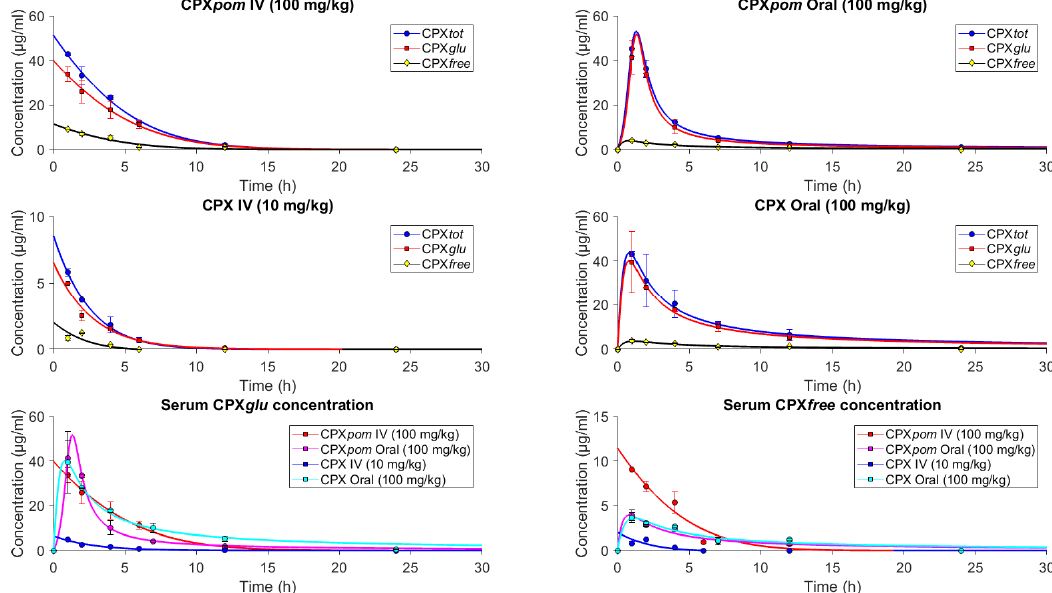
a Quantities referred to CPXtot. Abbreviations: AUC 0:12h : area under the curve for serum, integrated at 12 h; AUC (cid:2868):(cid:2870)(cid:2872) (cid:3035)(cid:3048)(cid:3045)(cid:3036)(cid:3041)(cid:3032) : area under the curve for urine, integrated at 24 h; C max : maximum circulating concentration; DM: administered dose; F 0:12h : (AUC 0:12h /Dose) oral /(AUC 0:12h /Dose) IV ; T 1/2 : time at which the concentration becomes half the dose; T max : time at C max ; IV: intravenous administration.